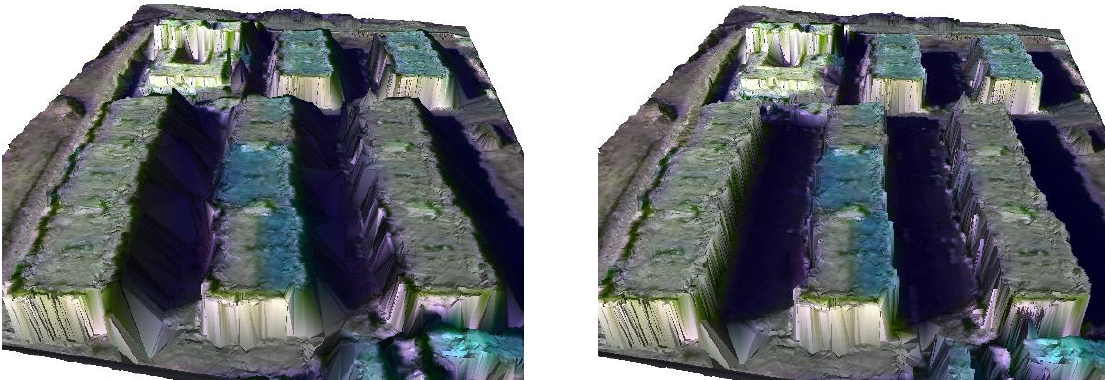
Figure 6. 3D reconstruction of high resolution satellite stereo images. Left: 3D reconstruction with shadow effect (standard SGM algorithm); right: 3D reconstruction after disparity map refinement (proposed